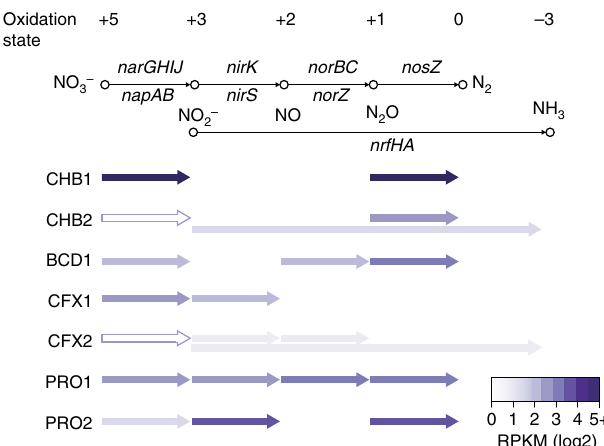
Figure 3 | Presence and expression of denitrification genes across the recovered heterotrophic genomes. Purple arrows indicate gene presence. Colour intensity represents gene expression (log2 RPKM), based on mapping of metatranscriptomic reads to the metagenomic assembly. An outlined white arrow indicates one or more enzyme subunits had no detectable gene expression. A summary of genes involved in denitrification across the recovered genomes can be found in Supplementary Data 4.